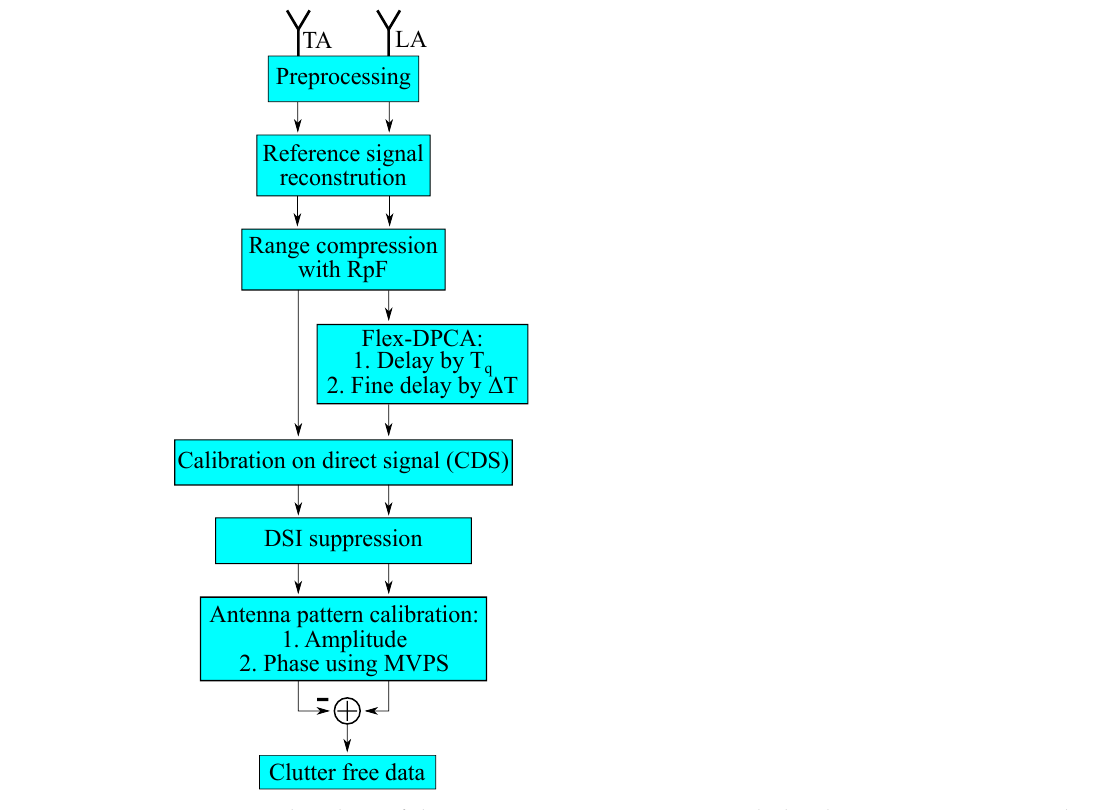
Figure 6. Flowchart of the processing. Preprocessing includes down-conversion, sampling, and synchronization on the direct signal. LA, Leading Antenna; TA, Trailing Antenna; DSI, Direct Signal Interference; MVPS, Minimum Variance Power